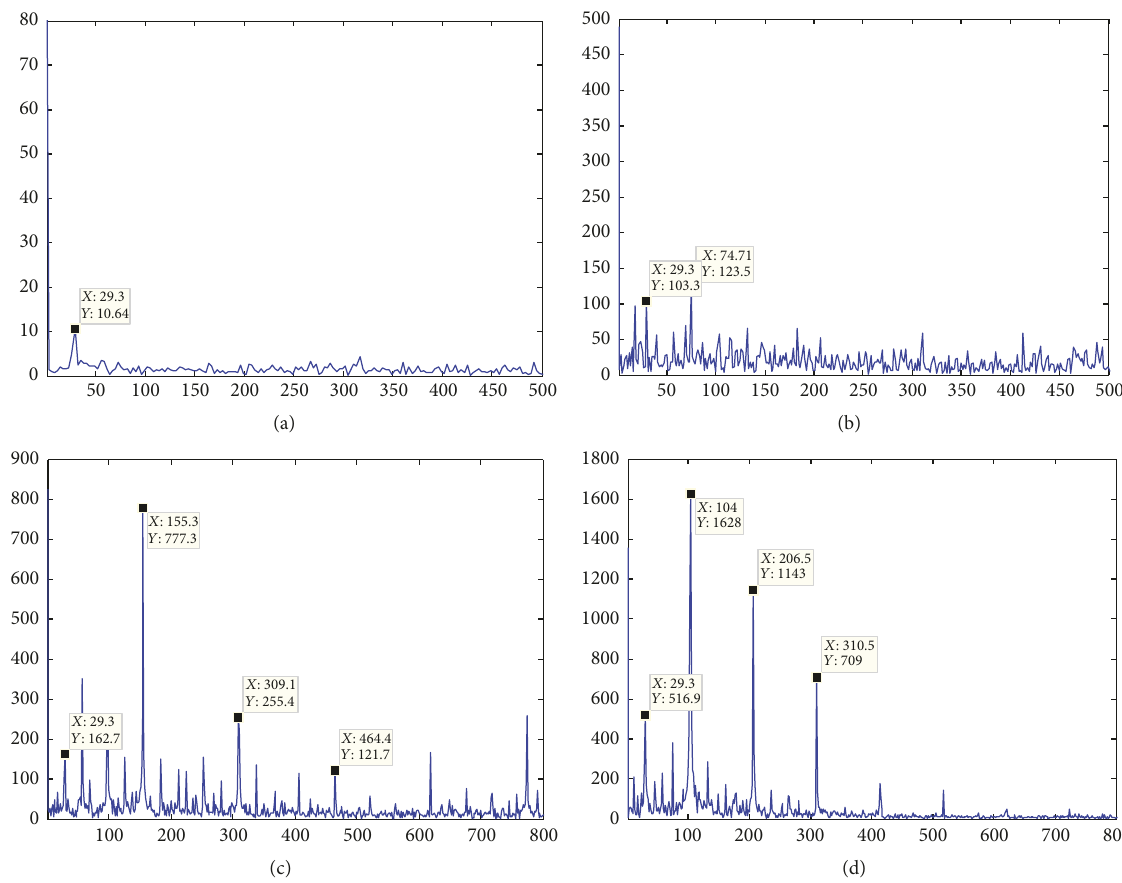
Figure 10: Hilbert envelope demodulation spectrum for (a) normal status, (b) rolling bearing fault, (c) inner ring fault, and (d) outer ring fault.